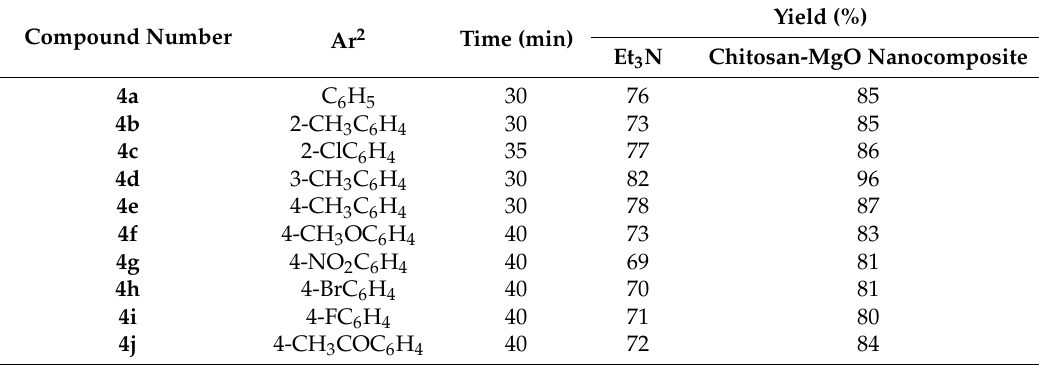
Table 2. Effect of the nature of basic catalyst on the yield of the products 4a – j